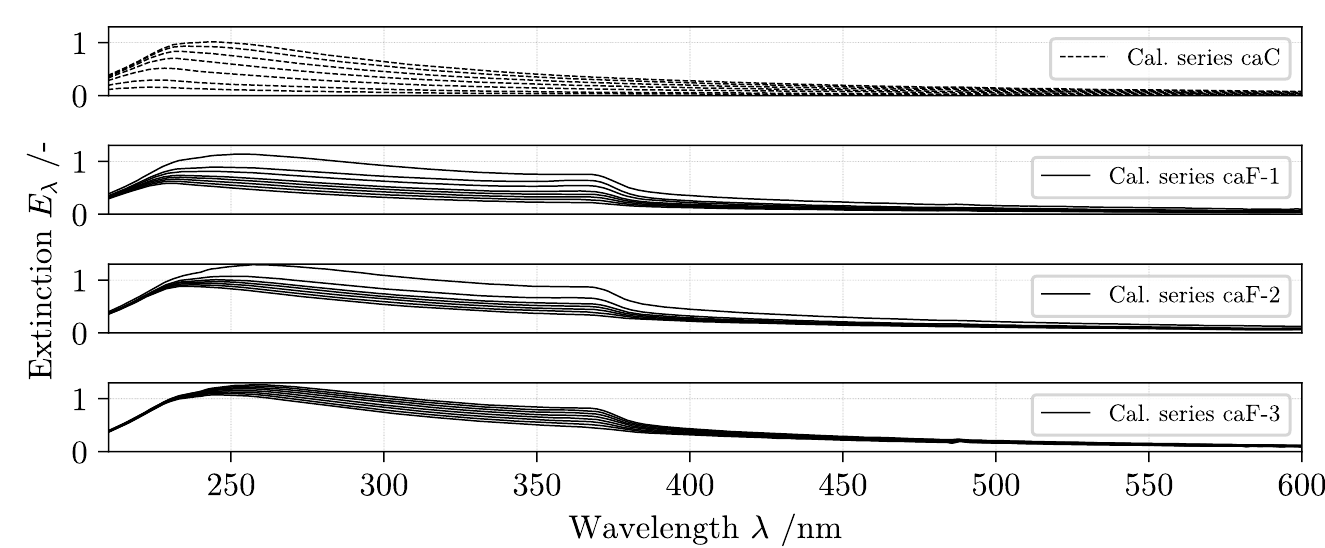
Figure 6. Overview of collected calibration spectra for classification ( caC ) and fractionation ( caF